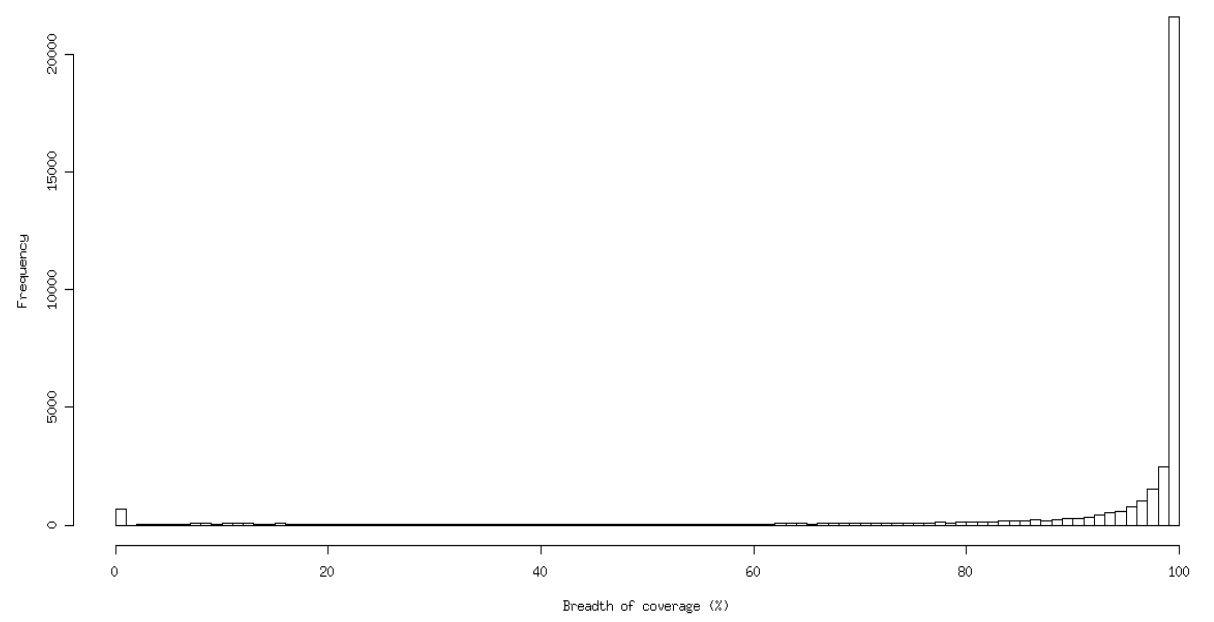
Figure 1. Frequency distribution for breadth of coverage on 36,542 banana gene sequences by enset whole-genome shotgun sequence reads aligned against the banana genome using